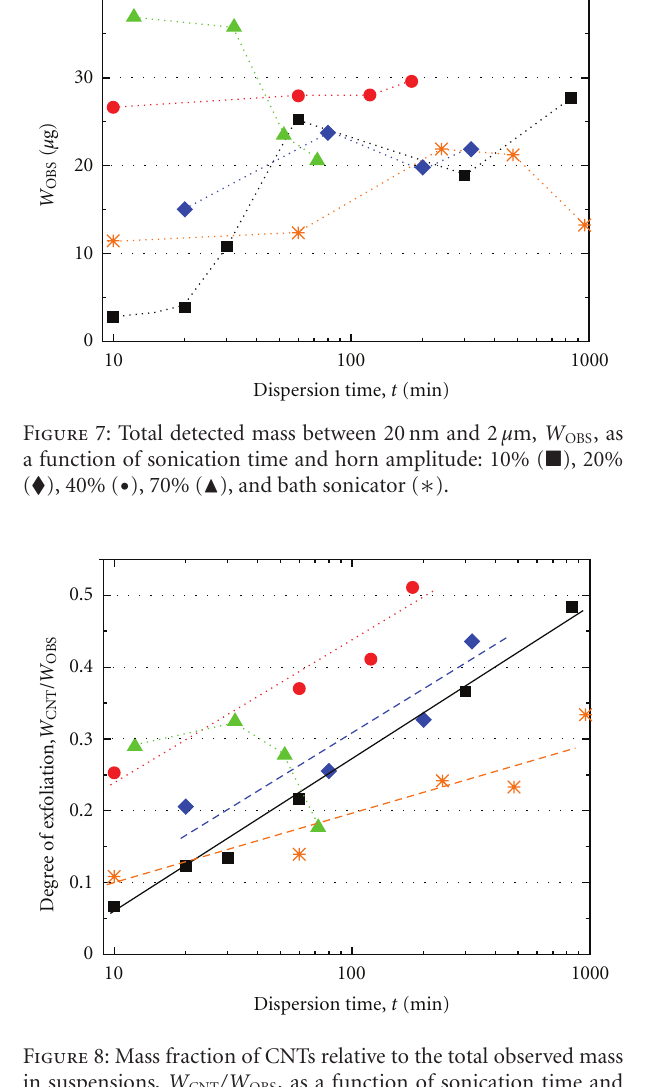
Figure 8: Mass fraction of CNTs relative to the total observed mass in suspensions, W CNT /W OBS , as a function of sonication time and horn amplitude: 10% ( (cid:2) ), 20% ( (cid:3) ), 40% ( • ), 70% ( (cid:4) ), and bath sonicator ( ∗ ). The straight lines are guides to the eye.